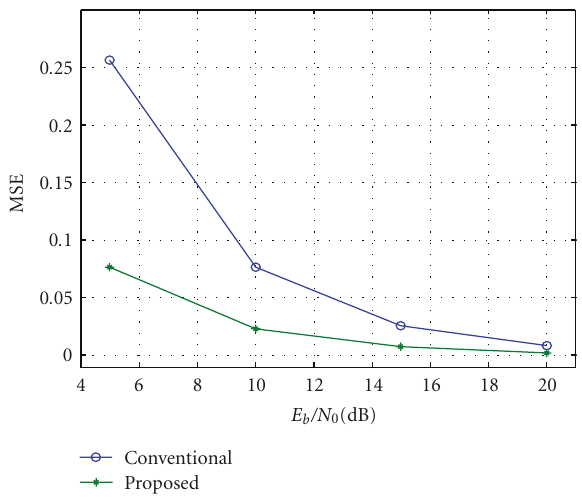
Figure 12: MSE performance comparison between conventional and proposed channel estimation for valid 12